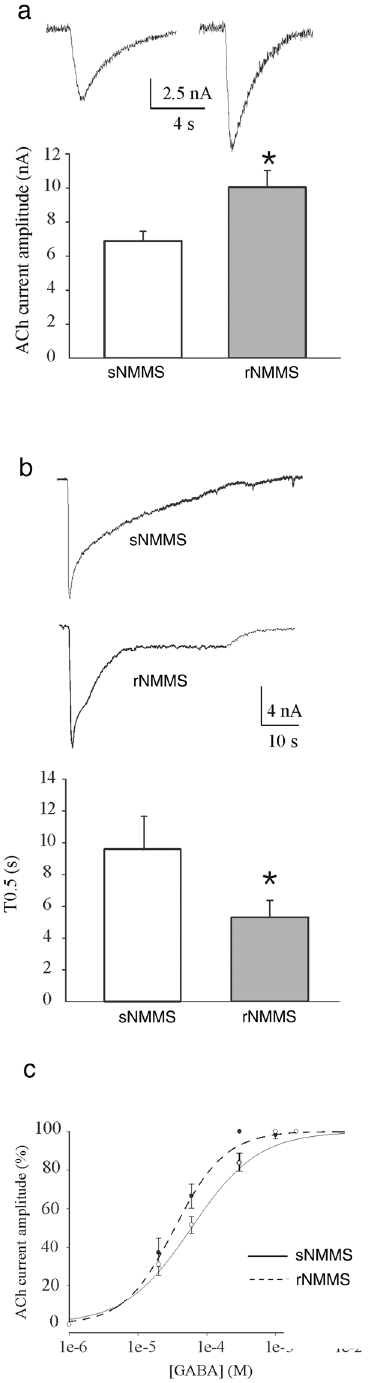
Figure 5. Electrophysiological analysis of ACh responses in sNMMS- and rNMMS. ( a ) The bar graphs show the mean ACh current amplitude (mean ± SEM) in sNMMS vs rNMMS injected oocytes. (Inset) Representative current traces from sNMMS (left) and rNMMS (right) injected oocytes. [ACh] = 500 μ M; 4 s applications. * p < 0.05. Note the increase in current amplitude after rNMMS. ( b ) The bar graphs show the mean ACh current decay time (mean ± SEM) in sNMMS vs rNMMS injected oocytes. (Inset) Representative current traces from sNMMS (upper) and rNMMS (lower) injected oocytes. [ACh] = 500 μ M; 30 s applications. * p < 0.05. Note the faster current decay time induced by rNMMS. ( c ) Averaged EC 50 values in oocytes injected with membranes from sNMMS and rNMMS patients, showing an increase in ACh affinity after rNMMS